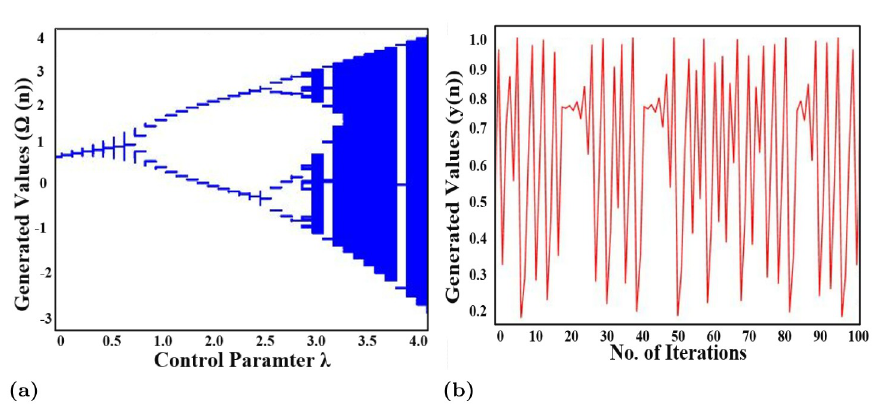
Fig 5. (a) Bifurcation diagram of CLM and (b) random sequence generated using CLM.